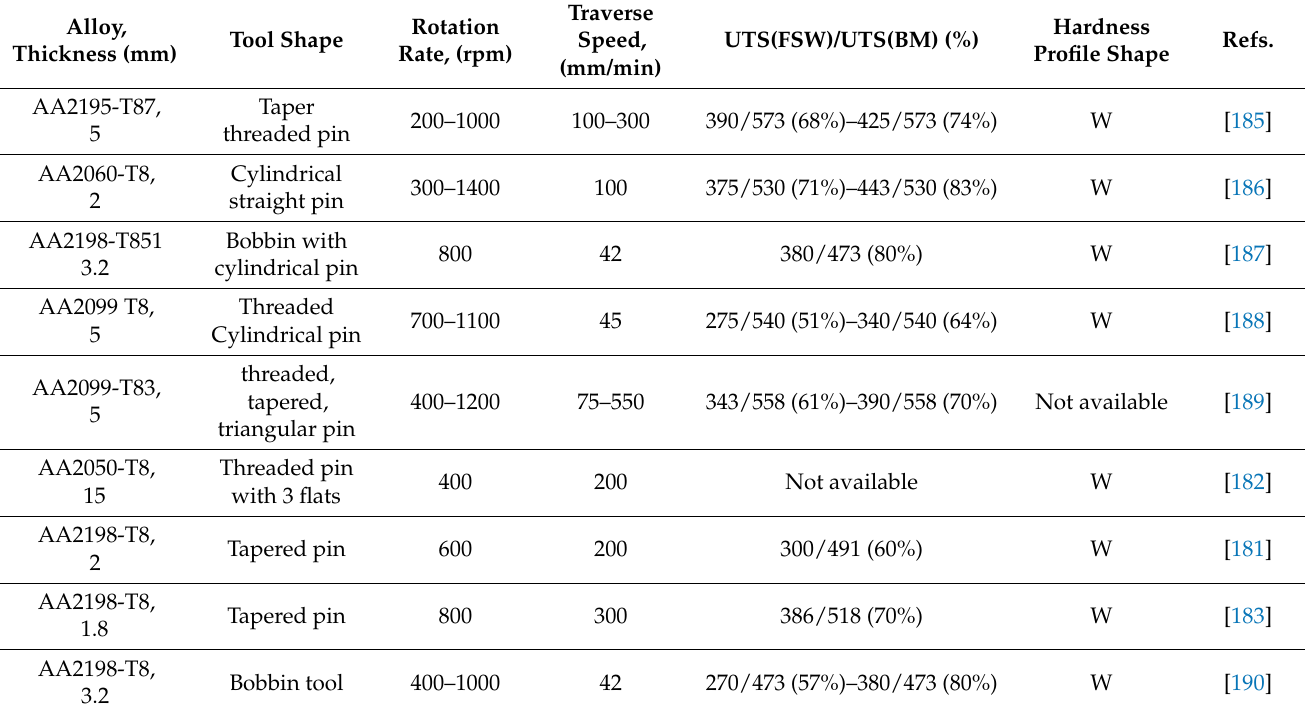
Table 3. Al–Li alloys FSW conditions and the resulting mechanical